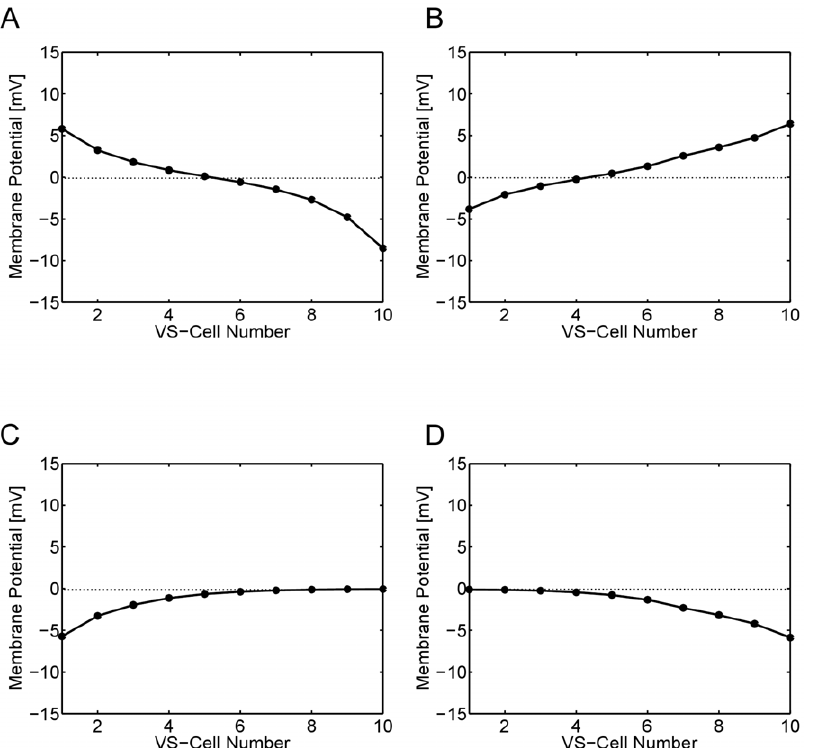
Figure 3. Response of VS-cells (axonal compartments) to injection of 10 nA depolarizing (a,b) and hyperpolarizing (c,d) current into the dendritic compartments of VS1 (a,c) and VS10 (b,c). With increasing distance from the injected cell, the effect gradually decreases. When the injected cell is depolarized, the cell at the opposite end becomes hyperpolarized (a,b). The reversal is not observed when hyperpolarizing current is applied.